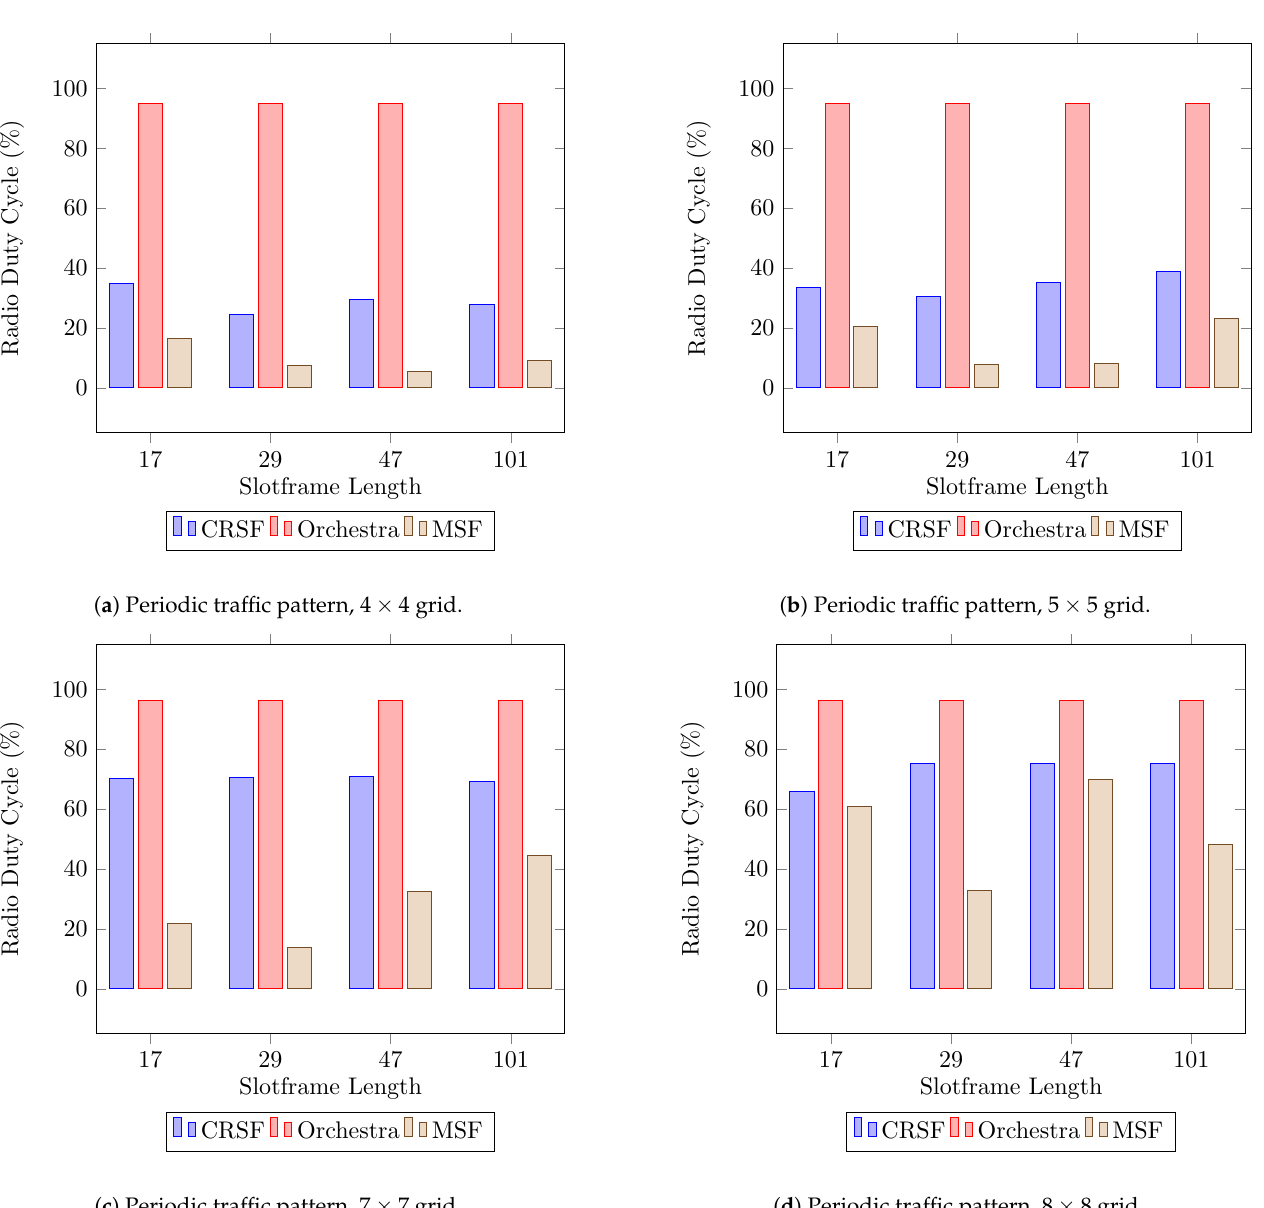
( c ) Periodic traffic pattern, 7 × 7 grid. ( d ) Periodic traffic pattern, 8 × 8 grid. Figure 7. Average radio duty cycle performance using a periodic traffic pattern. Lower is